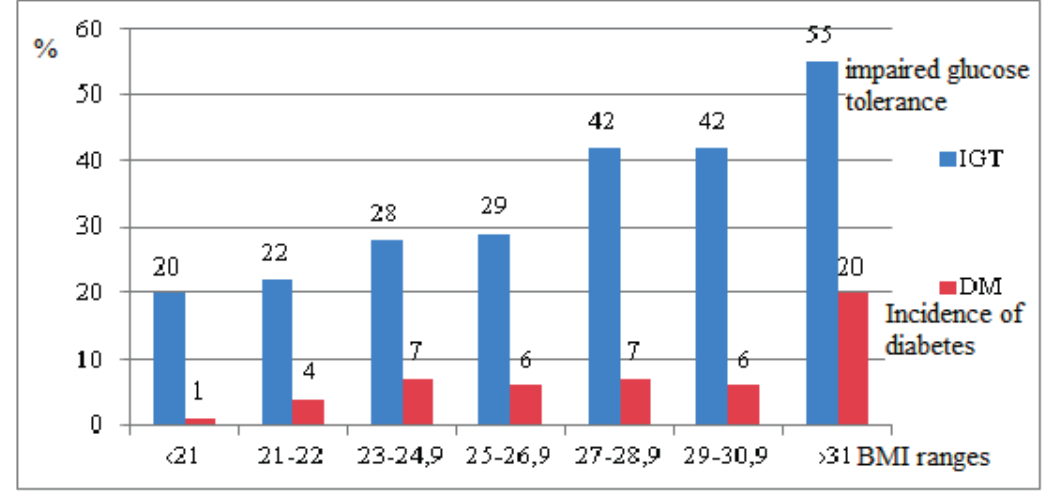
Figure 1. The likelihood of developing diabetes increases along with the degree of obesity, IGT-impaired glucose tolerance, x axis—BMI ranges, y axis—Incidence of diabetes and IGT (%)